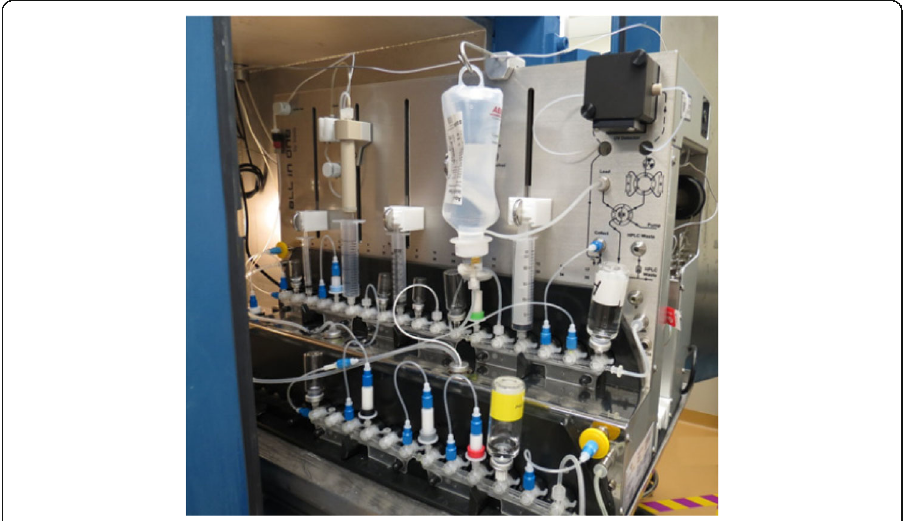
Fig. 2 AllinOne synthesis module with mounted disposable kits and reagents for [ 18